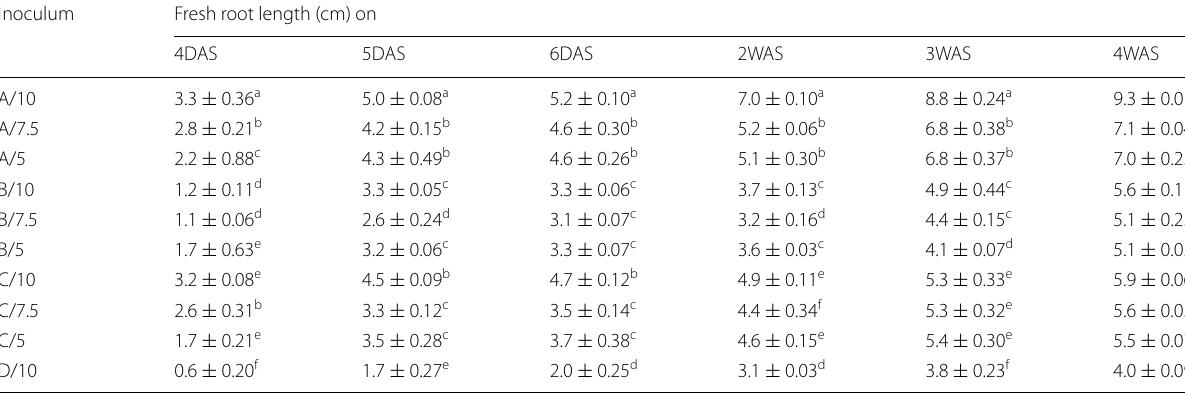
DAS Days after sowing, WAS Weeks after sowing. Results with similar alphabetic superscripts on same column did not differ from each other ( p >0.05). A10, A7.5 = = and A5.0 10 ml, 7.5 ml and 5.0 ml of Bacillus sp., respectively. B10, B7.5 and B5.0 = ml and 5.0 ml of Klebsiella sp ., respectively. D10 10 ml of =